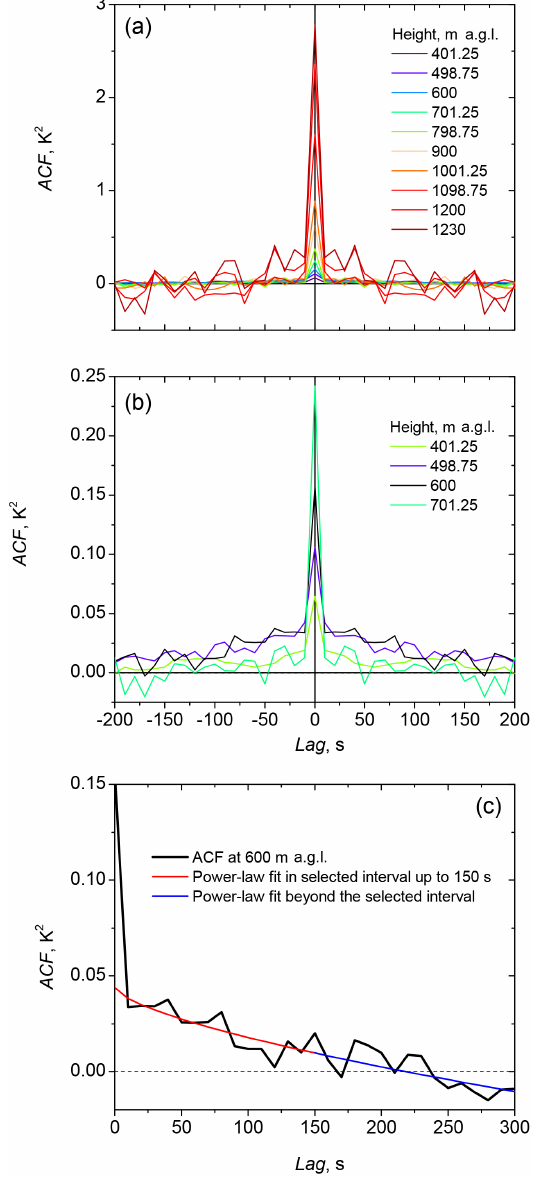
Figure 6. (a) Autocovariance functions (ACF) around the zero lag obtained at different heights from the temperature measurements shown in Fig. 5, i.e., with the data of 24 April 2013 between 11:00 and 12:00UTC. (b) Zoom of (a) for lower heights only. (c) ACF with power-law fit for